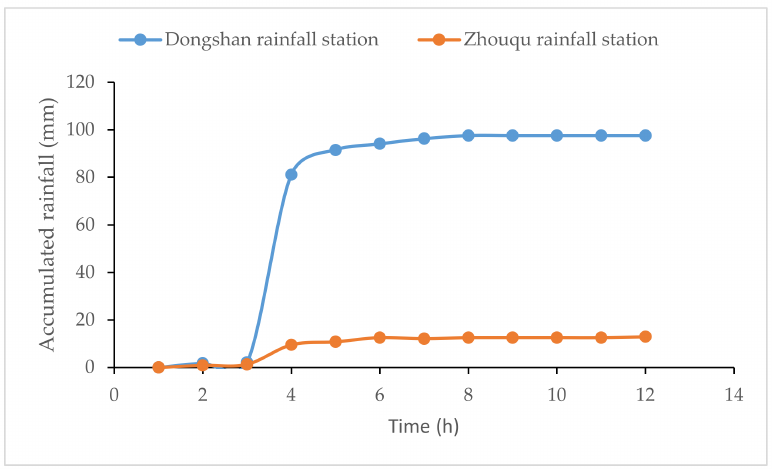
Figure 4. Precipitation leading up to Zhouqu debris flow as measured at Dongshan and Zhouqu rainfall station.